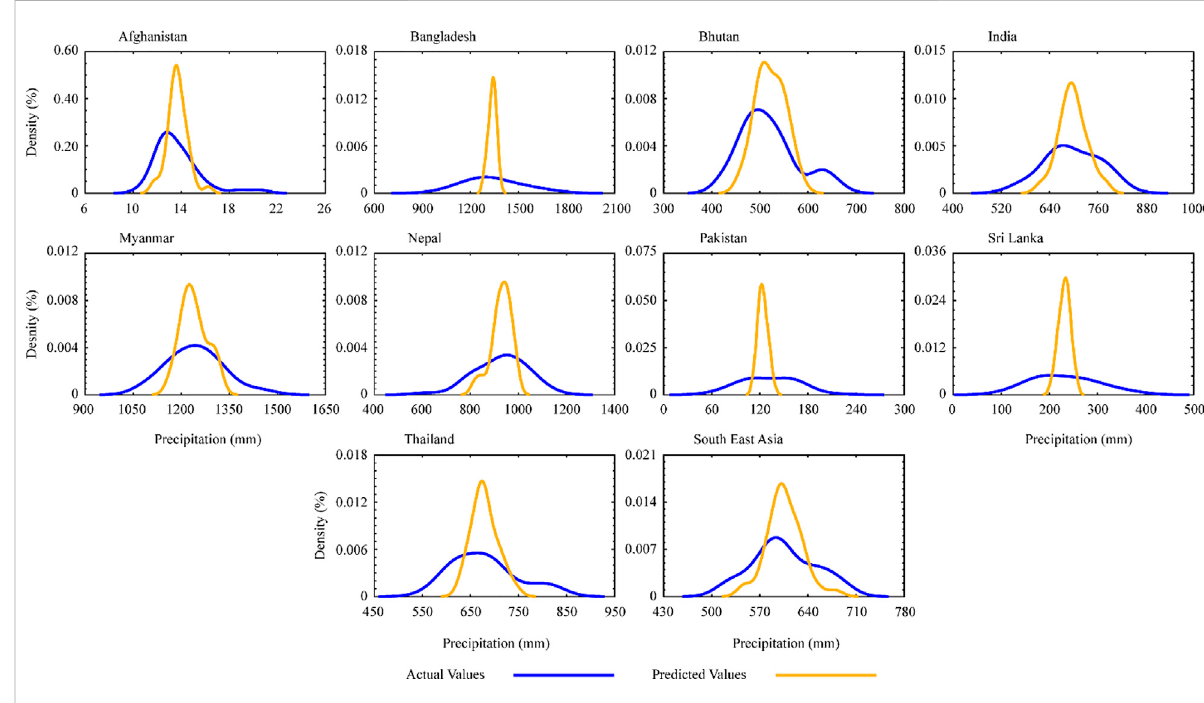
FIGURE 10 Probability distribution function of spring actual and predicted precipitation values during 1981 – 2020.